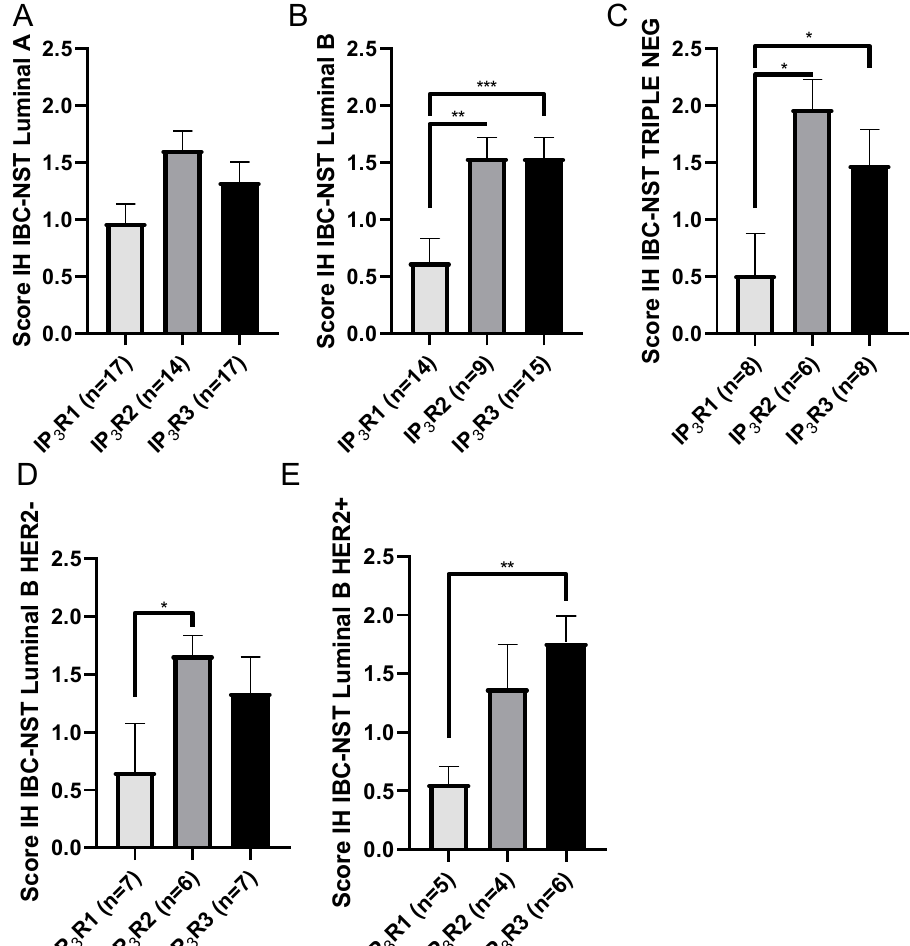
Figure 5. IP 3 R expression score as a function of the BC molecular subtype. ( A ) Luminal A, ( B ) luminal B, ( C ) triple negative, ( D ) luminal B HER2-, and ( E ) luminal B HER2+ BC. * p < 0.05; ** p < 0.01; *** p < 0.001.